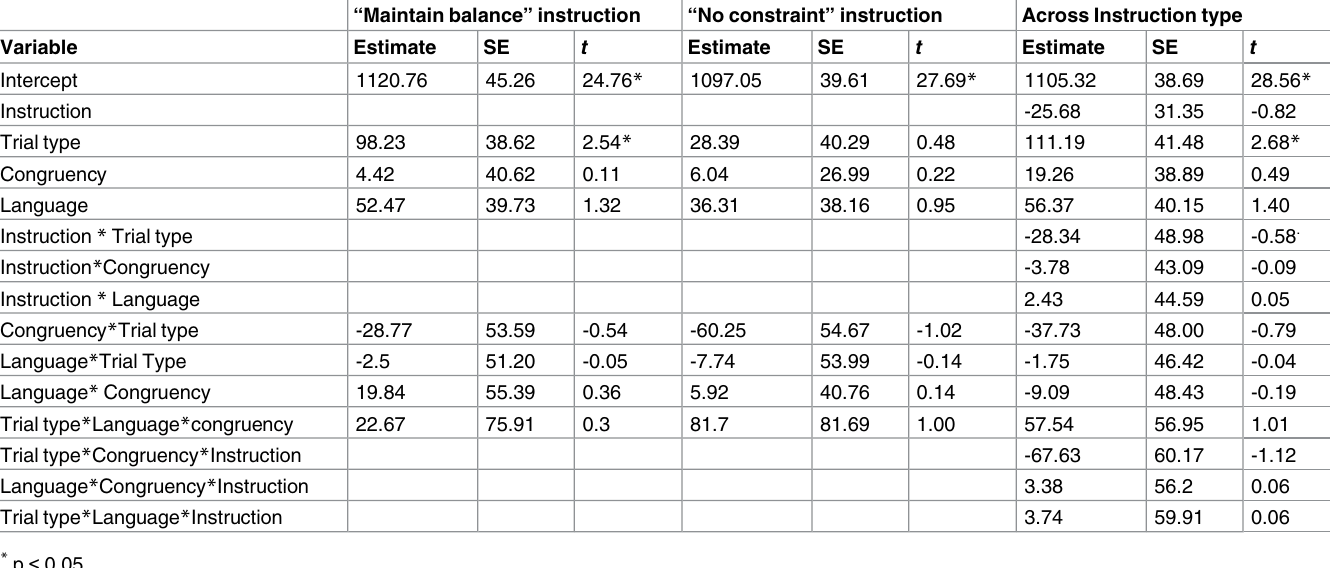
Table 4. Results on Naming latency in the voluntary block (Experiment